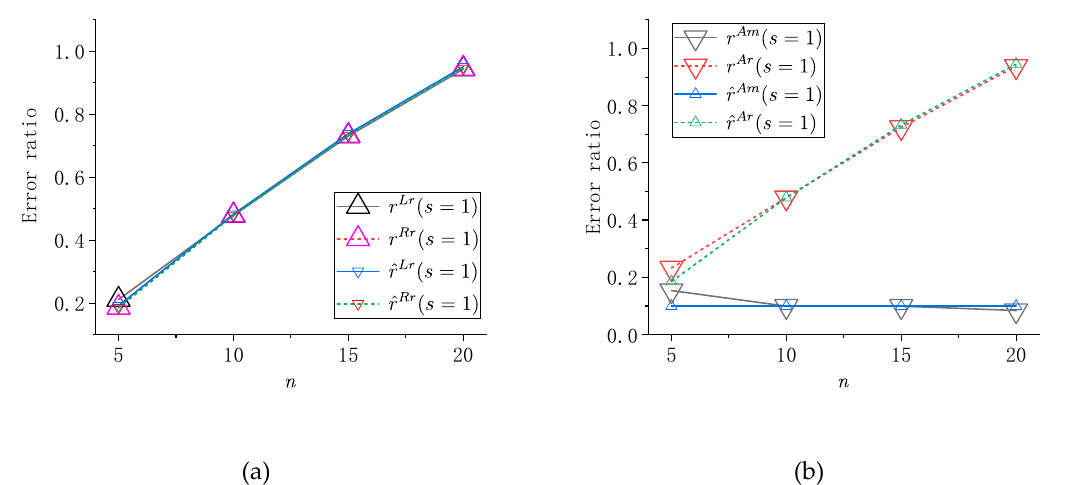
Figure 9. Comparison of estimated error ratio and numerical results for di ff erent size of structures when di ff erent modeling methods are used, ( a ) r Lr and r Rr , ( b ) r Am and r Ar .